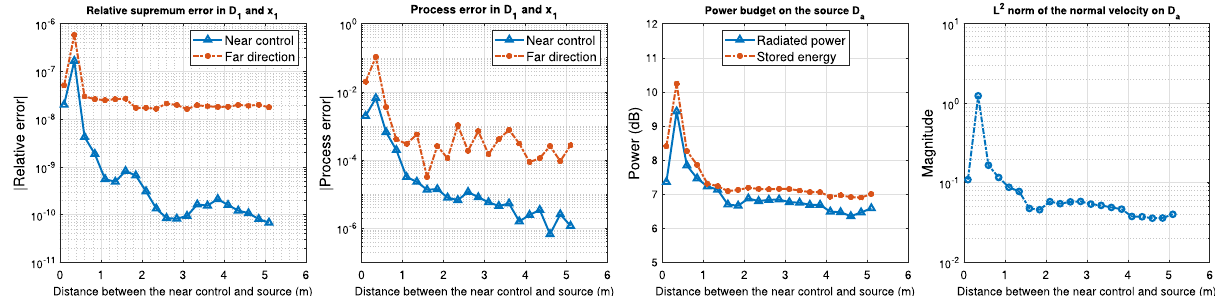
Figure 10. Results showing the control accuracy and the power budget varying with mutual distance between D 1 and D 0 to right, (1) Supremum error. (2) Process error. (3) Power budget on D a . L 2 norm of normal velocity v n on D a .